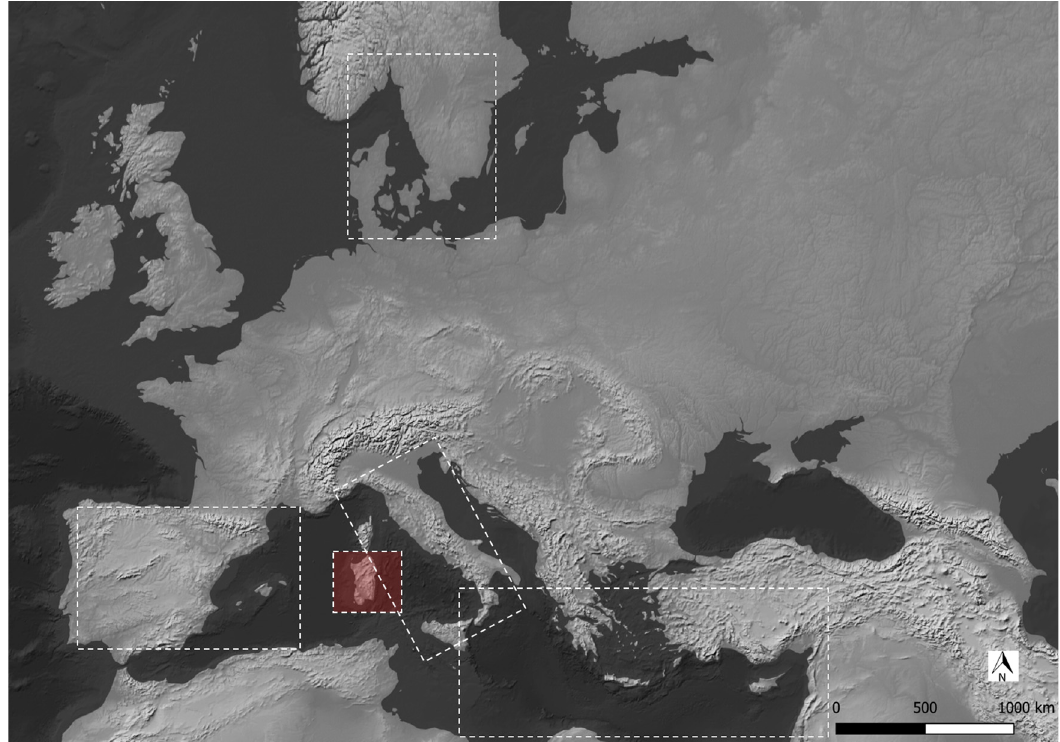
Figure 1: Sardinia ’ s geographical position invites seaborne connections with other Mediterranean regions and even the Atlantic region. The island ’ s large size and central position in the western Mediterranean Sea is favorable, c. 700 km beeline from Gibraltar as the access point to northern tracts. Eastern cargo ships, by comparison, had to pass Sicily before arriving at Sardinia, c. 1,200 km beeline from Cyprus ( map V. Matta )